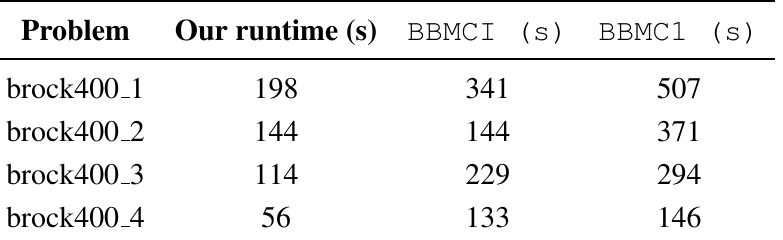
Table 1. Comparison of runtimes (in seconds) for our sequential implementation with San Segundo’s published results for BBMCI [11] (which differs slightly from our algorithm) and with runtimes using Prosser’s BBMC1 [12] (which is the same as our algorithm, but in Java). The system used to produce these results has the same model CPU as was used by San